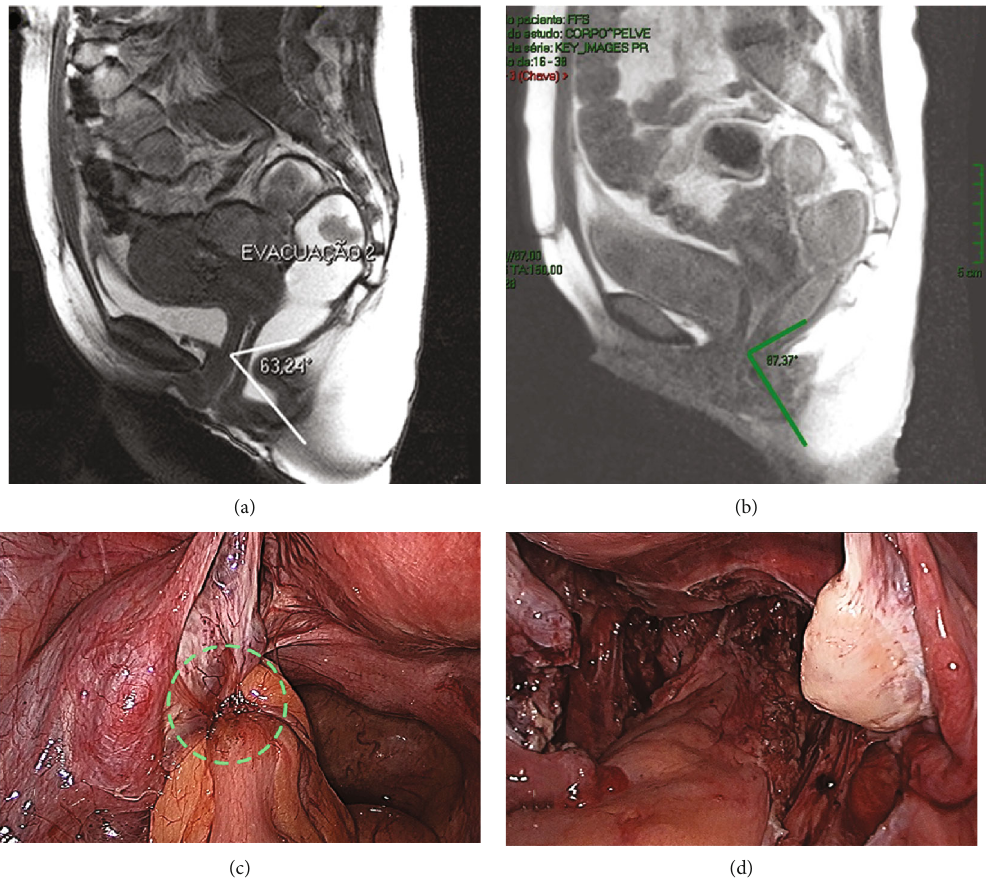
Figure 1: Sagittal dynamic magnetic resonance defecography: (a) assessment with Fast Imaging Employing Steady-State Acquisition (FIESTA) technique performed prior to surgery exhibiting paradoxical contraction of the puborectalis muscle during simulated defecation straining (anismus), a defecation anorectal angle of 63 ° (exerting stenosis); (b) assessment with single-shot fast spin echo sequence performed 3 months after nerve-sparing segmental colorectal resection identifying anismus, with a smaller reduction of the defecation anorectal angle of 87 ° and easier elimination of the rectal gel. Anorectal angle during defecation is normal when higher than at rest. The de fi nitions and boundaries are according to Brandão and Ianez [9]. Panoramic laparoscopic view: (c) in the beginning of the surgery presenting intestinal endometriotic nodule adhered to the left uterine annex (dashed green circle); (d) after segmental colorectal resection with the rectosigmoid in anatomical